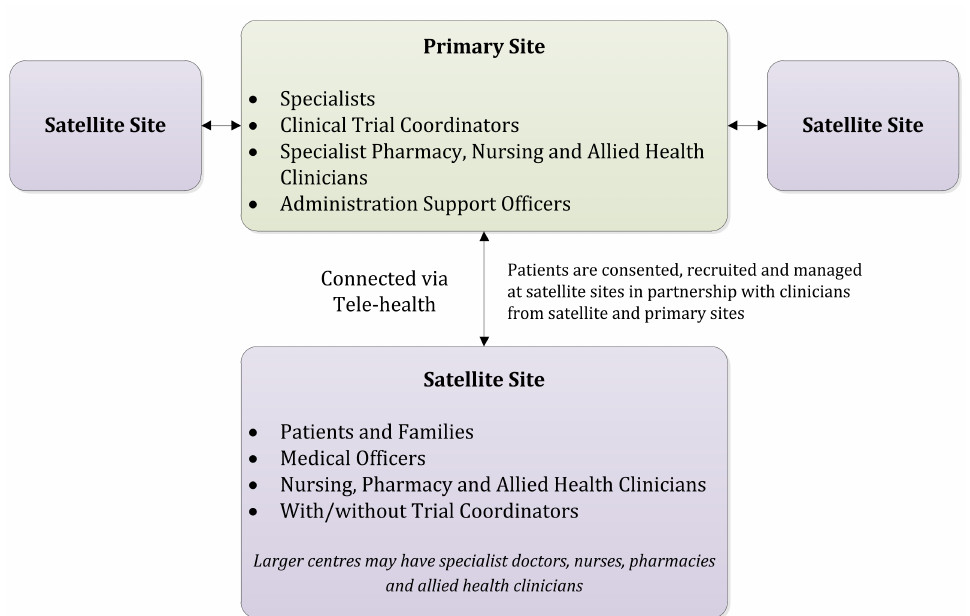
Figure 1. A trial cluster from the Australasian tele-trial model. Adapted from Clinical Oncology Society of Australia, Australasian Tele-Trial Model: A National Guide for Implementation. 2016.